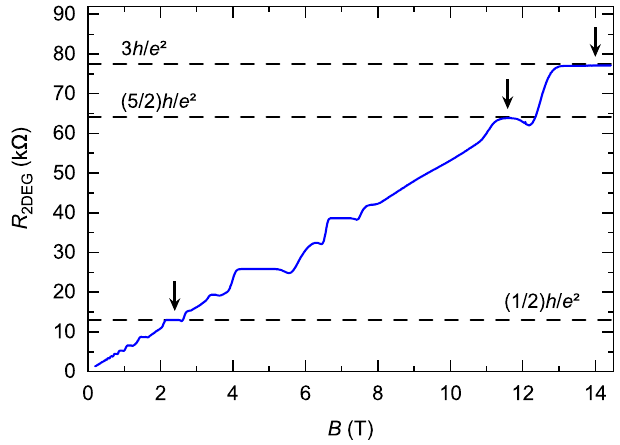
FIG. 9. Quantum Hall resistance plateaus. Two-wire resistance between an Ohmic contact and cold grounds measured as a function of the applied perpendicular magnetic field B at low temperature ( T ∼ 100 mK). Dashed lines show the fractional quantum Hall resistances h= ν e 2 for the investigated fractions ν ¼ 1 = 3 , 2 = 5 , and 2. Vertical arrows indicate the magnetic field at which the measurements are